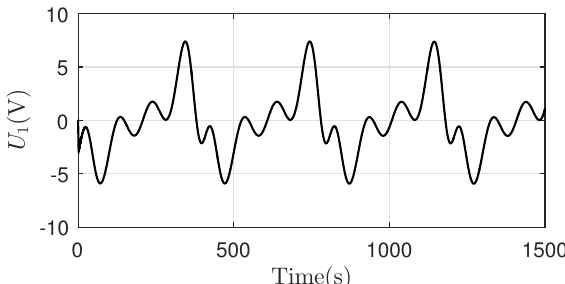
Figure 26. Control input U 1 in floating motion with a constant velocity and variable pitch angle command.